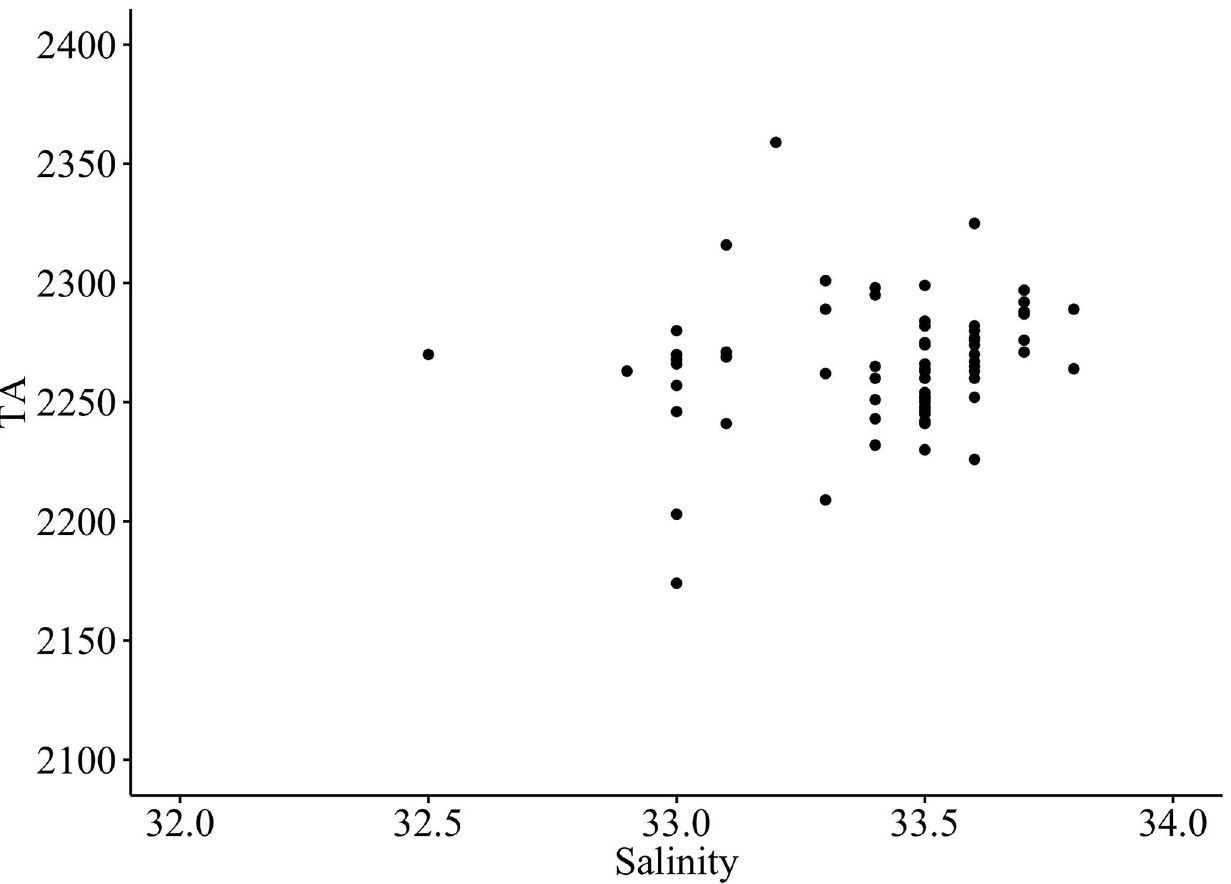
Fig 2. Relationship between salinity and total alkalinity (r 2 = 0.014, n = 70).